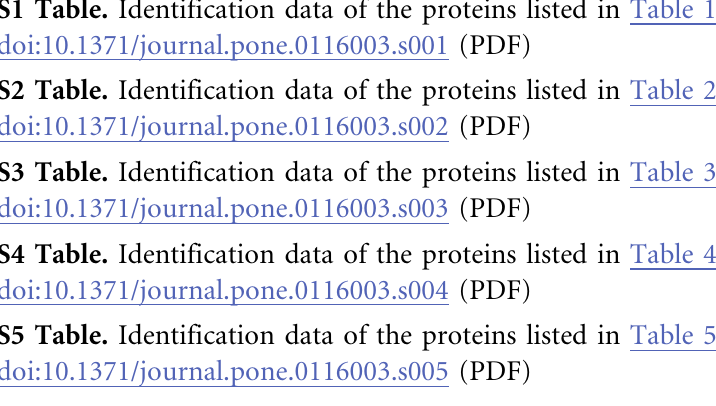
S1 Table. Identification data of the proteins listed in Table 1. S2 Table. Identification data of the proteins listed in Table 2. S3 Table. Identification data of the proteins listed in Table 3. S4 Table. Identification data of the proteins listed in Table 4. S5 Table. Identification data of the proteins listed in Table